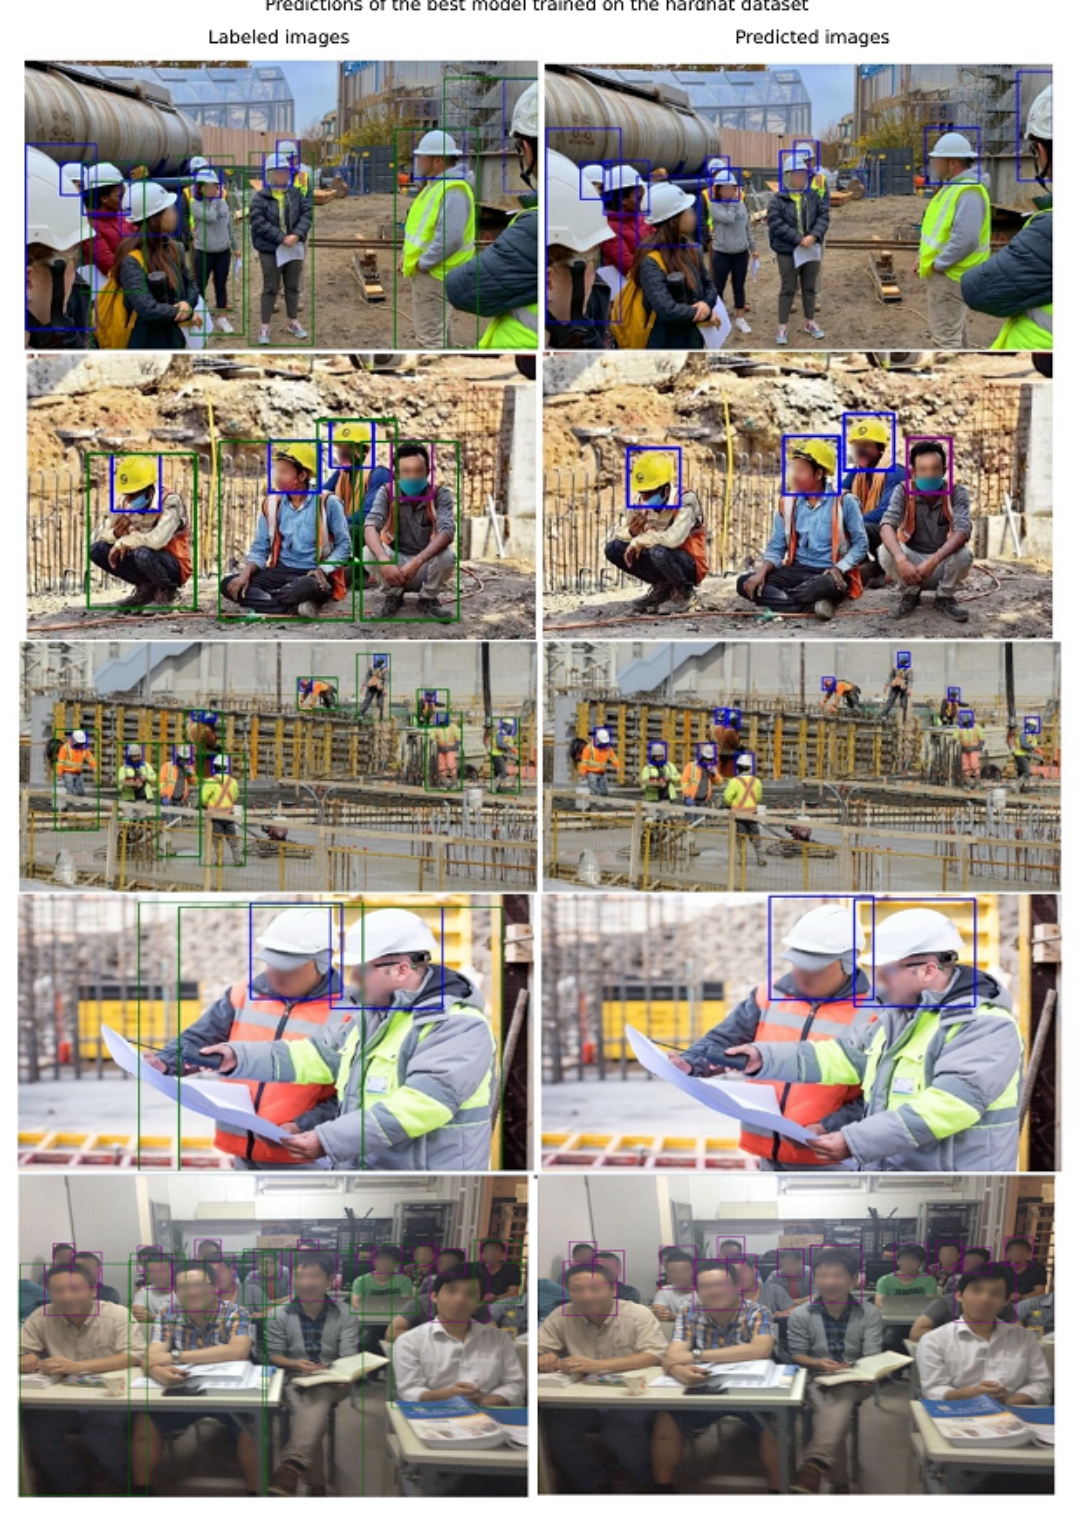
Figure A2. Predictions of the best model trained on the hardhat dataset [20] and the ground truth labels of the sample